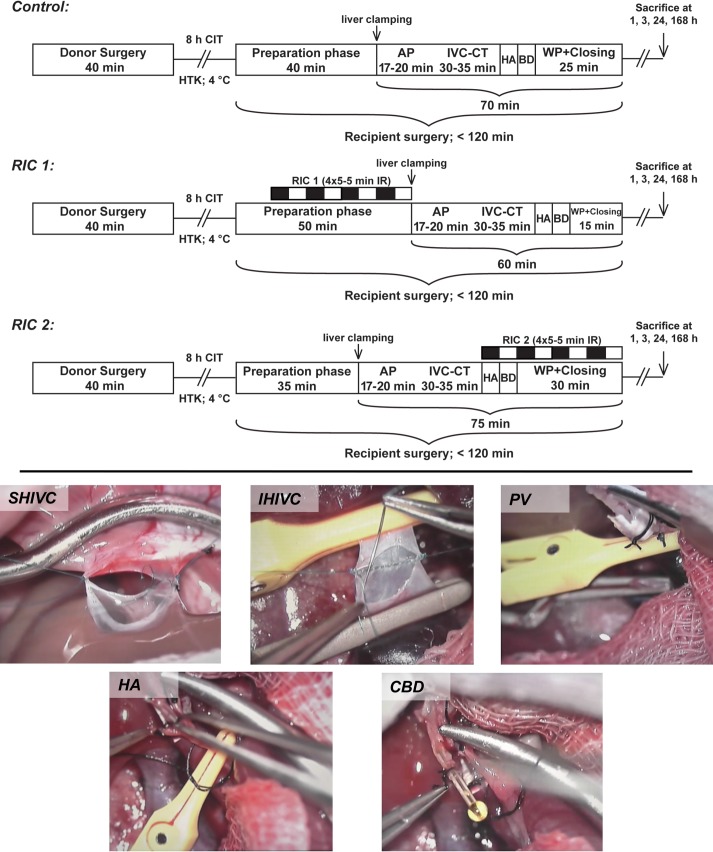
Study flowchart and microsurgical technique.Animals were randomized into three experimental groups (Control, RIC 1, RIC 2). Following liver retrieval, grafts were stored for 8 h in cold HTK solution and implanted into the recipient animals. In the RIC 1 and RIC 2 groups, remote conditioning (4x5 min IR via exclusion of the infrarenal aorta) was applied before the anhepatic phase or after reperfusion, respectively. Short waiting periods have been implemented to keep the recipient procedures in the same time range in all experimental groups. Animals were sacrificed after 1, 3, 24, and 168 h of reperfusion for sample collection and further analysis (n = 6/group/time point). Representative photographs are demonstrating the used microsurgical approach for liver transplantation. Original magnification 8-16x. SHIVC: 7–0 Prolene one-way up running suture; IHIVC: 8–0 Prolene one-way up running suture; PV: Cuff technique, using 14 G cuffs; CBD and HA: Splinting with 24 G polyethylene splints. Abbreviations used: CIT-cold ischemic time; HTK-Histidine-tryptophan-ketoglutarate solution; AP-anhepatic phase; IVC-CT-inferior vena cava clamping time; HA-hepatic artery; CBD-common bile duct; WP-waiting period; RIC-remote ischemic conditioning; IR-ischemia reperfusion; SHIVC-supra hepatic inferior vena cava; IHIVC-infra hepatic inferior vena cava; PV-portal vein.